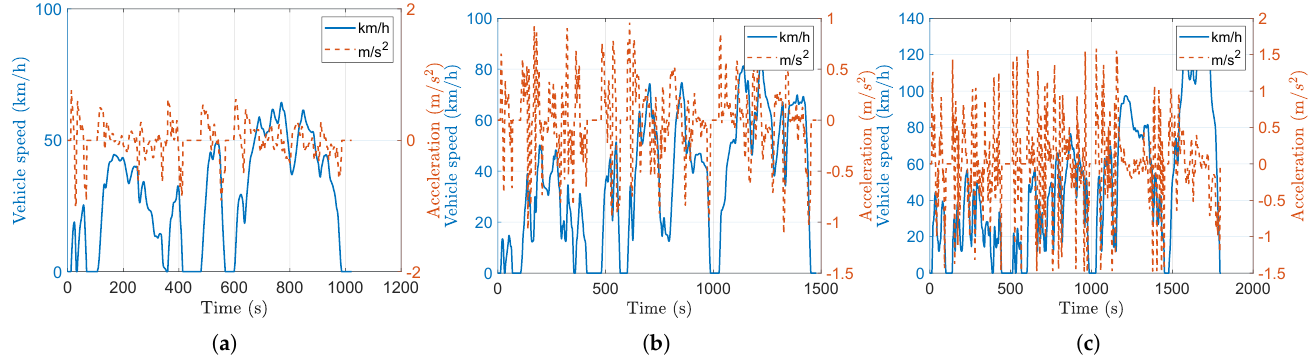
Figure 1. WLTP driving cycles for validation. ( a ) Class 1: Power-to-weight in W/unladen mass in kg < = 22. ( b ) Class 2: Power-to-weight ratio in W/unladen mass in kg > 22 but < = 34. ( c ) Class 3: Power-to-weight ratio in W/unladen mass in kg > 34.